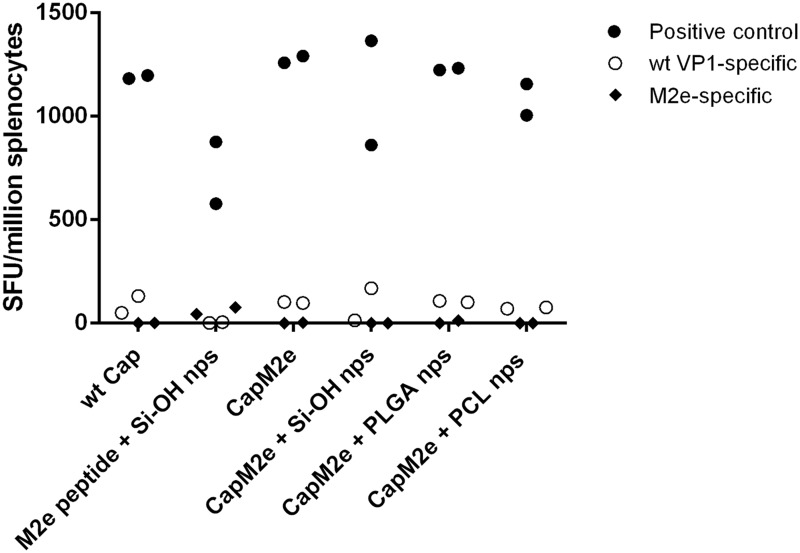
Determination of IFNγ response in splenocytes.M2e-specific T-cell response was evaluated by measuring IFNγ secreting cells by enzyme-linked immunospot (ELISPOT). A) Carrier (wt VP1)-specific, B) M2e-specific, C) positive control (Concanavalin A (Con A)). No significant difference was observed between the mean value of each group (p>0.05).